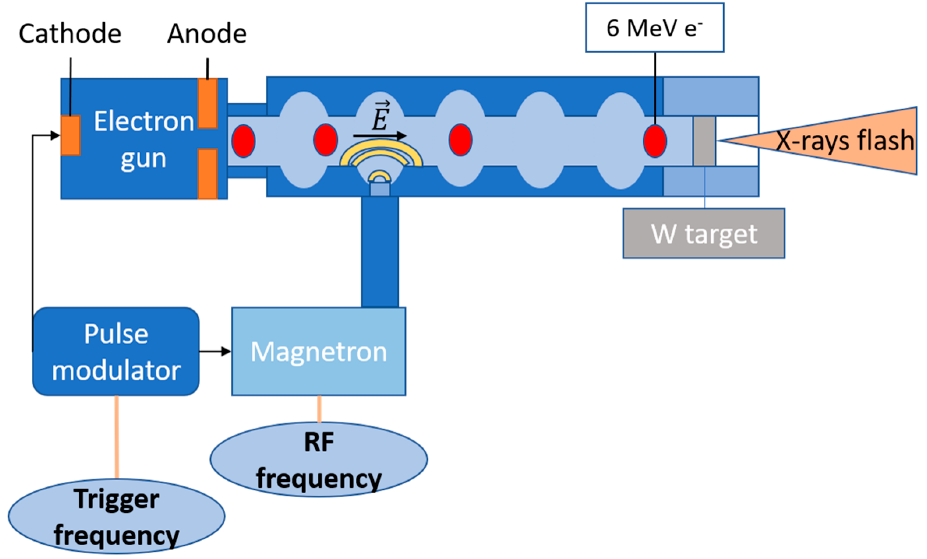
Figure 1. ORIATRON operation scheme.